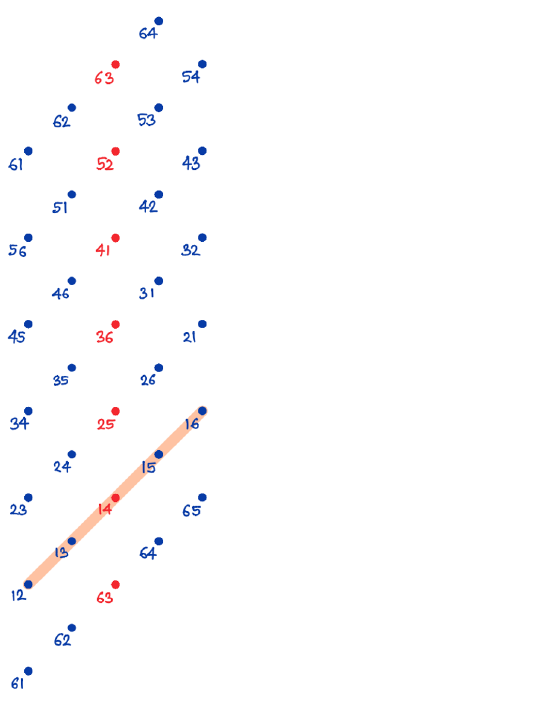
Figure 6 . Colored Causal Diamond with initial slice (13) , (14) , (15) where (14) is